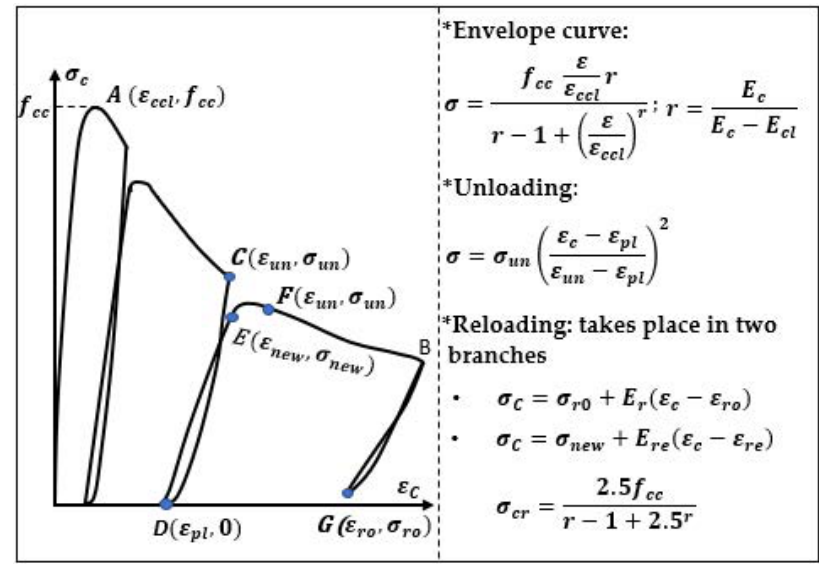
Figure 6. Concrete model according Martinez-Rueda [32].